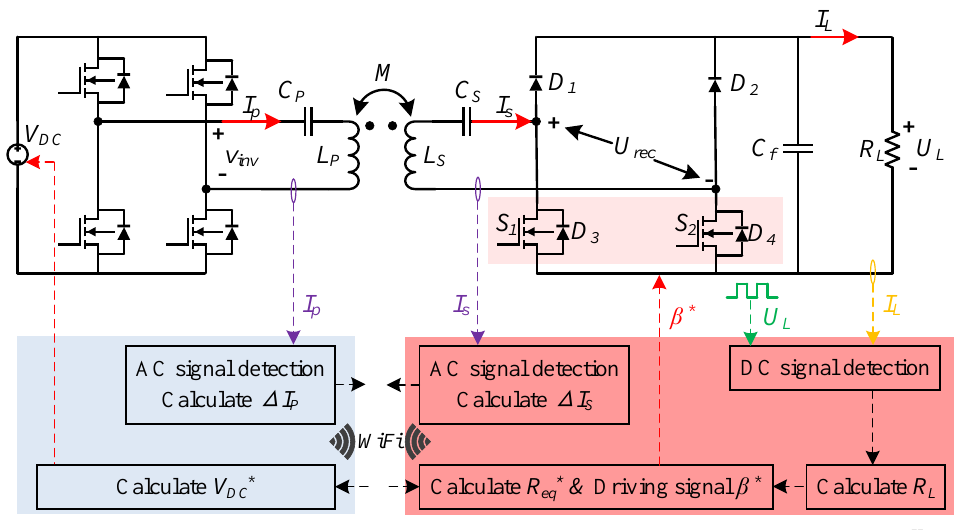
Figure 9. Schematic diagram of constant current control. Table 5. Symbol explanation in Figure 9.